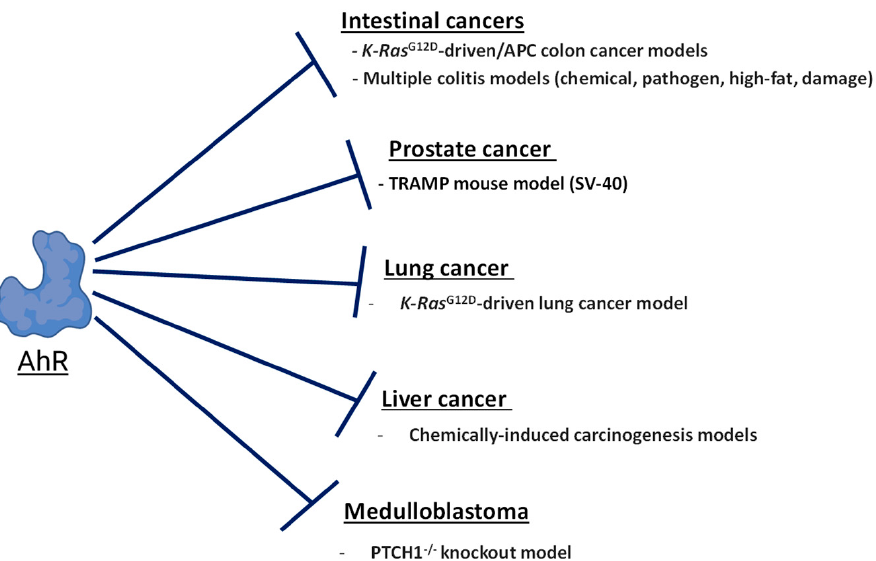
Figure 3. The role of AhR in tumor suppression. The diagram shows a summary of mouse cancer models where the expression of AhR opposes carcinogenesis.